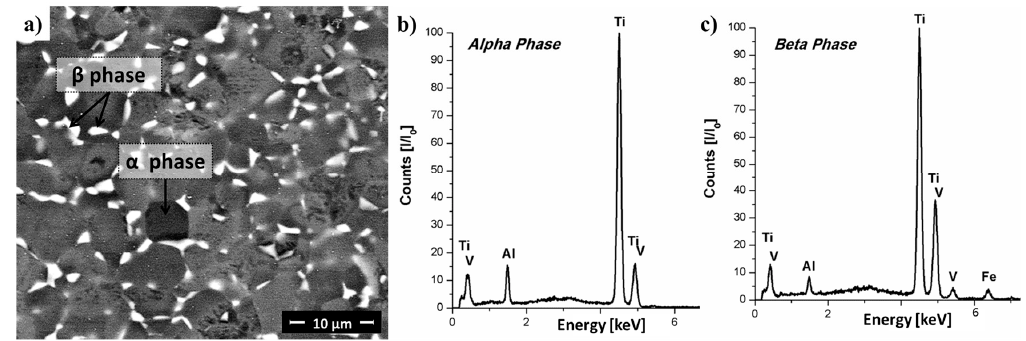
Table 1. Experimental chemical composition of Ti-6Al-4V alloy rivets.